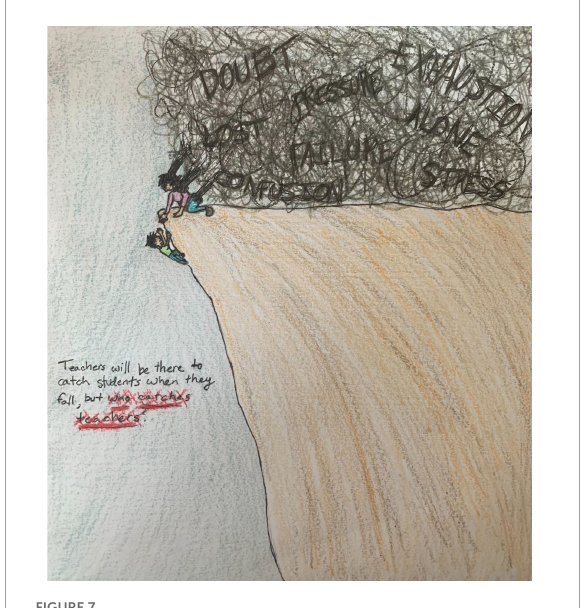
FIGURE7 Who catches teachers? Spring